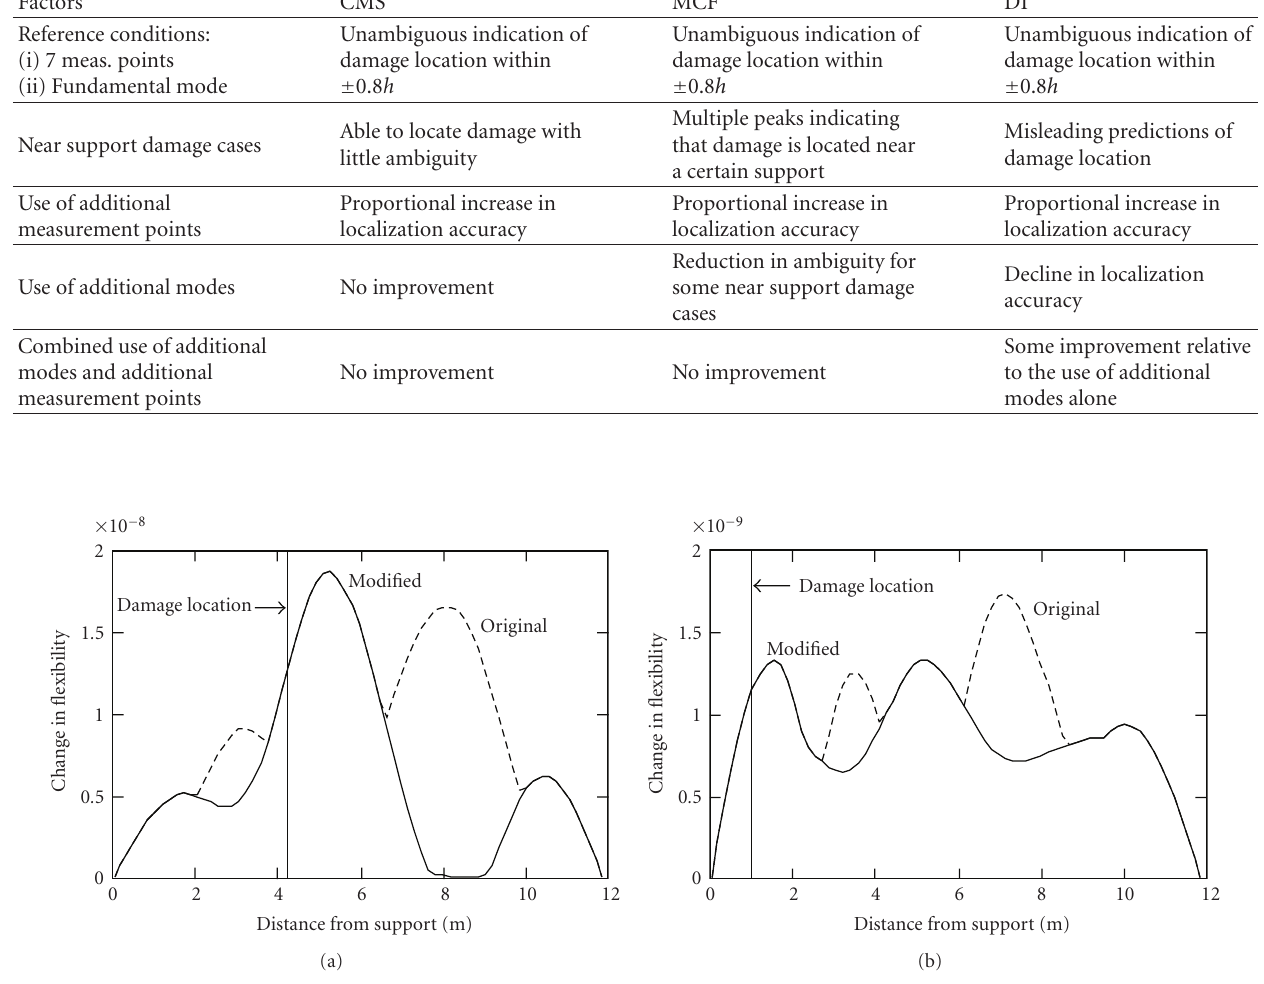
Figure 17: Distribution of change in flexibility by original and modified methods for experimental damage cases (a) 5 and (b)